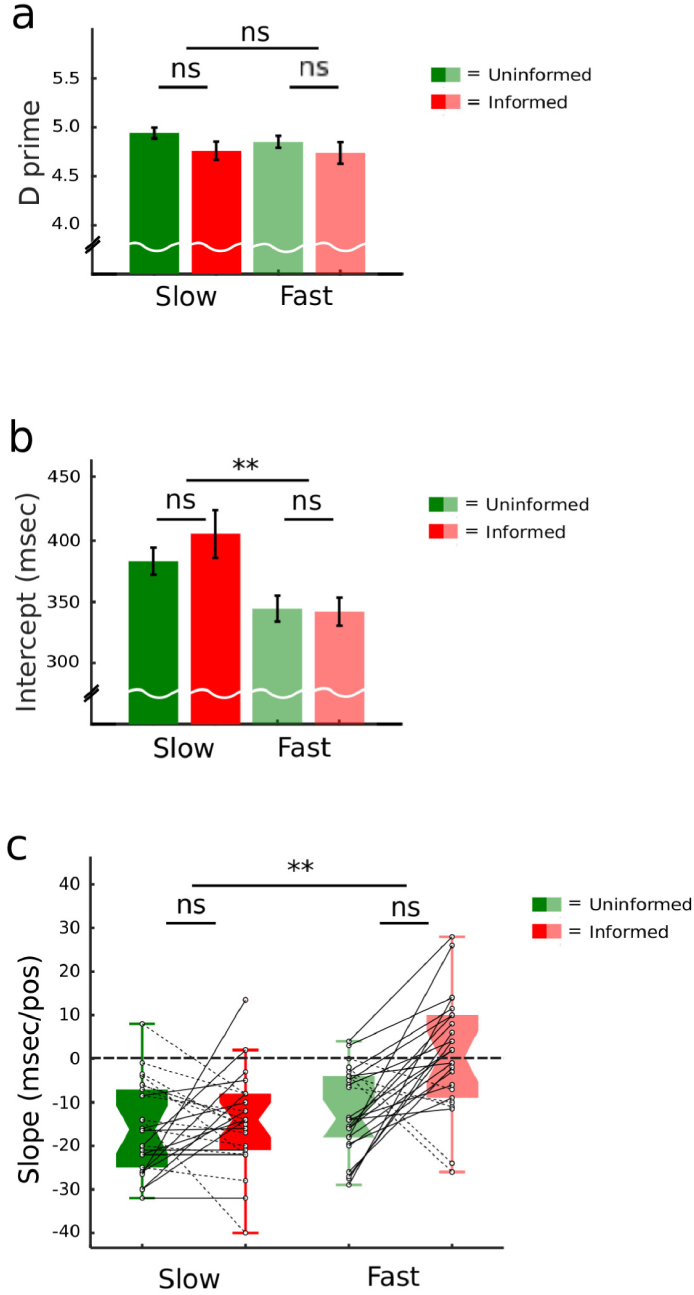
Fig 2. Behavioral results. A: Accuracy as reflected by target detection sensitivity measures (collapsed across potential target position). Error bars represent the Standard Error of the Mean (SEM). B: Means ± SEM of estimated response time intercepts across potential target positions, showing no statistically significant difference among conditions. C: Boxplot with median (middle of each box), interquartile range and whiskers (1.5 time the interquartile range) of estimated response time slopes suggesting the presence of the hazard rate driving response speed in slow stimulus trains, regardless of prior information (participants being uninformed or informed about actual target probabilities), and in fast stimulus trains with uninformed participants. Providing prior information in fast stimulus trains effectively cancelled time-dependent (position-wise) changes in response time, that is, the hazard rate.